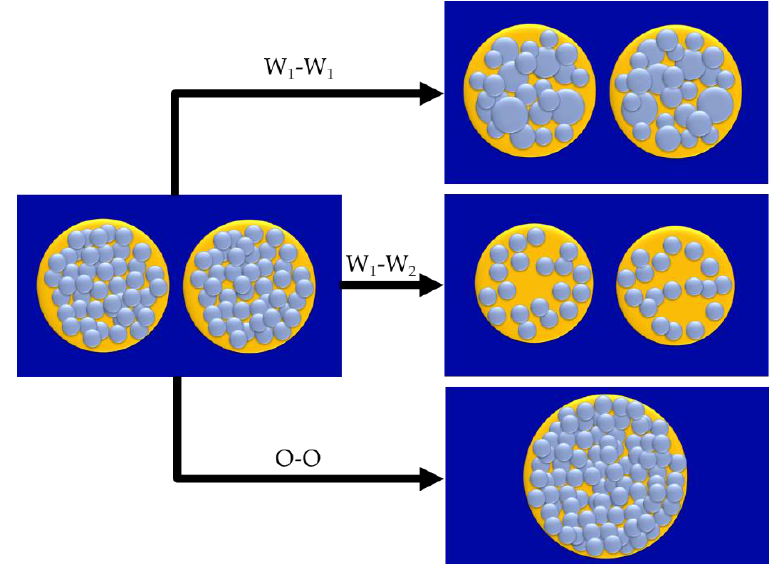
Figure 1. Possible coalescence paths in a monodispersed double emulsion. In the inner water phase (light blue), an active ingredient can be encapsulated. The oil phase (yellow) has a lipophilic surfactant dissolved within to stabilize the water droplets. The outer water phase (dark blue) has a hydrophilic surfactant to stabilize the oil droplets. This work focuses on the coalescence of oil droplets. Figure adapted from Leister and Karbstein [4].